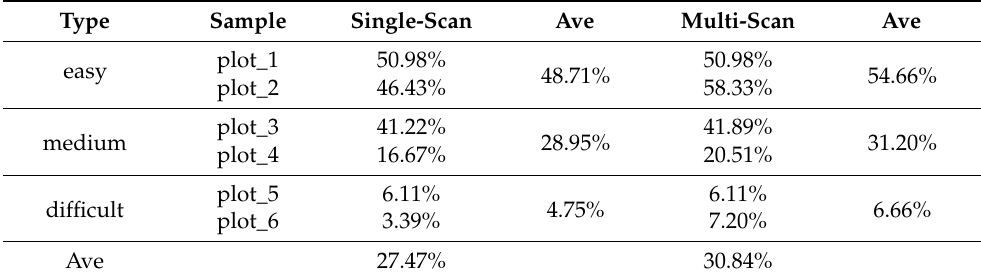
Table 5. Trunk stems detection rate by the transductive transfer learning for different plots.